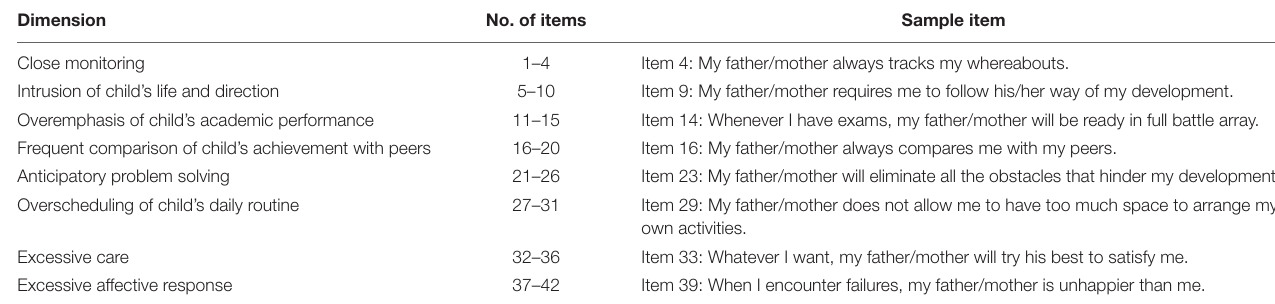
TABLE 1 | Sample item of each dimension of Chinese paternal/maternal overparenting scales. Dimension No. of items Sample item Close